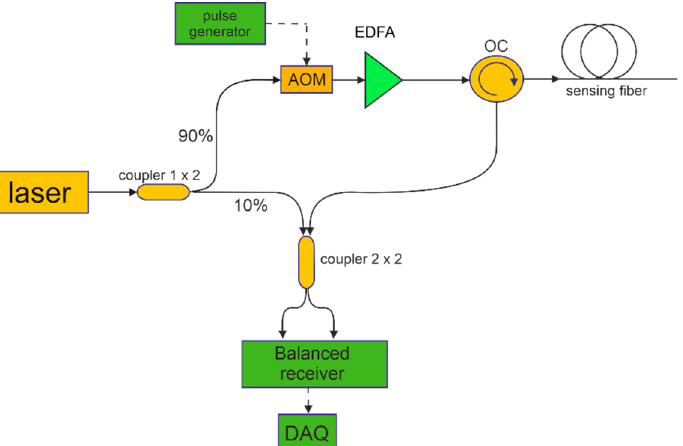
Figure 1. Experimental setup employed for Lamb wave detection based on the ϕ -OTDR method. AOM: acousto-optic modulator; EDFA: erbium-doped fiber amplifier; OC: optical circulator; DAQ: data acquisition.